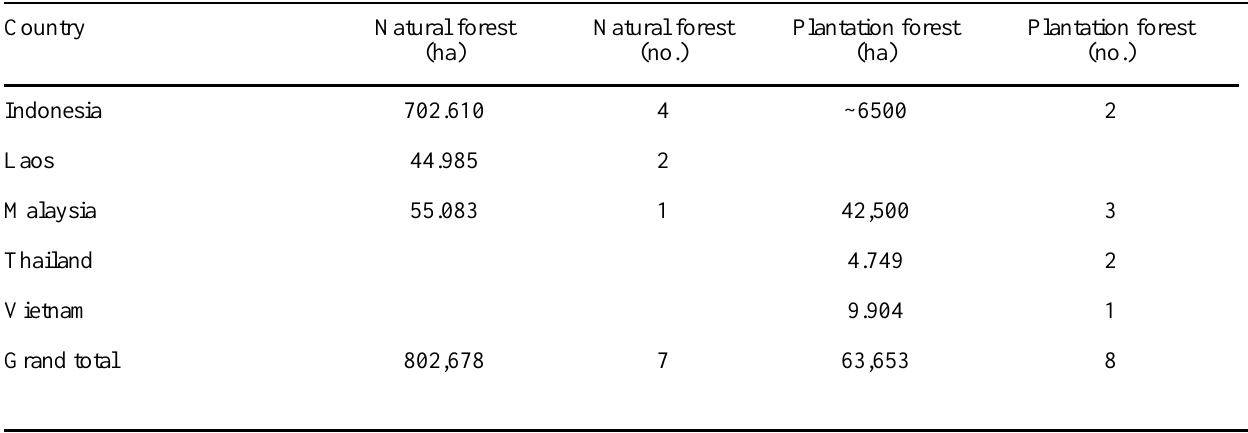
Table 4. Overview of natural and plantation forests in Southeast Asia certified by the Forest Stewardship